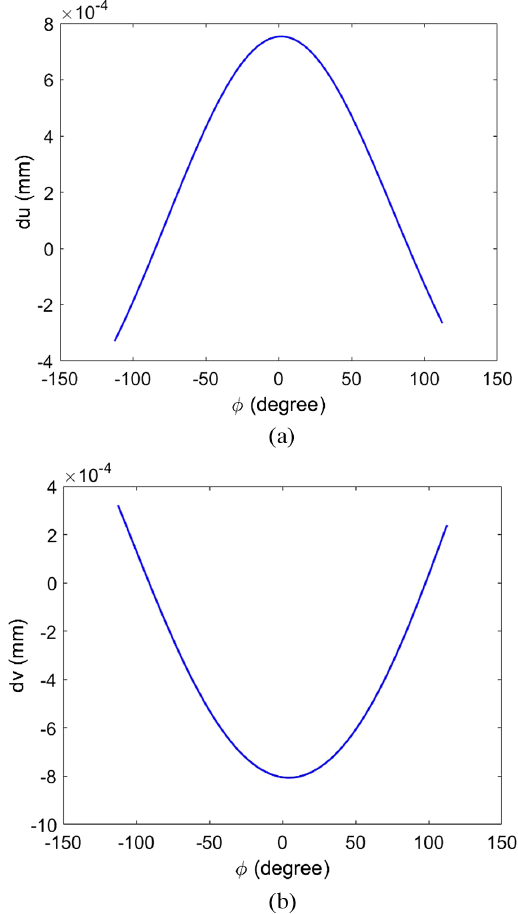
FIG. 12. The theoretical adjusting resolutions in the directions of (a) horizontal and (b) vertical.